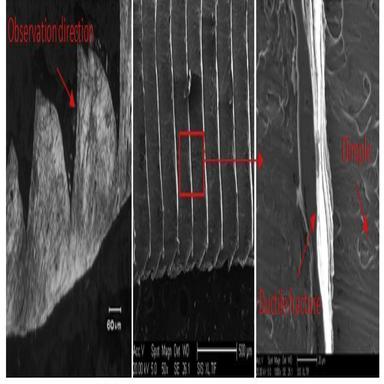
Micrograph of serrated chip.